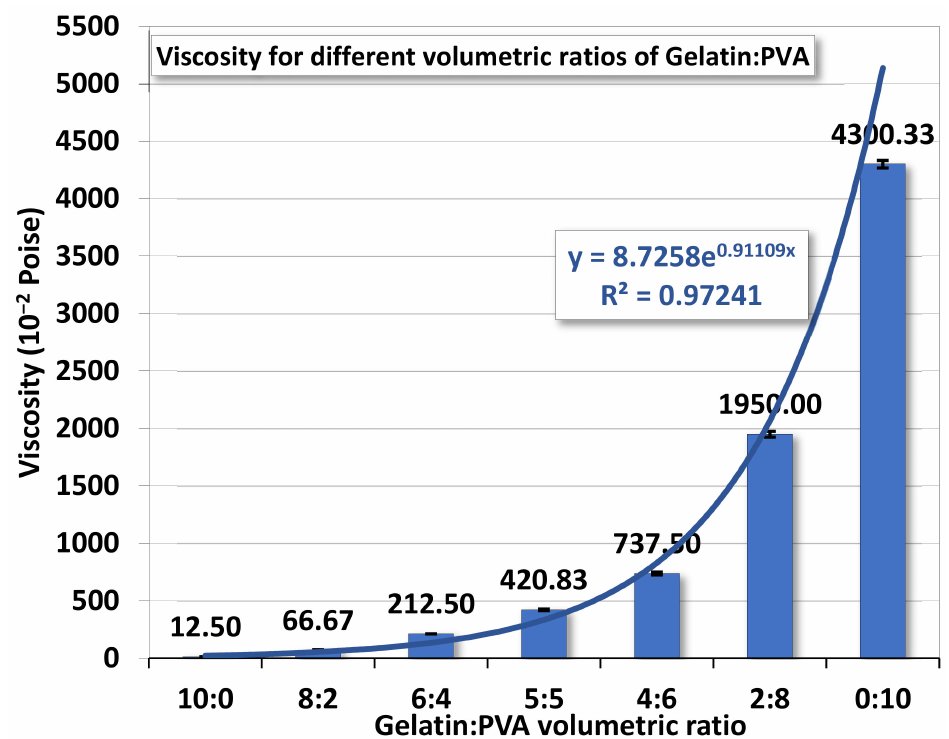
Figure 2. The averaged viscosity of gelatin/PVA mixed